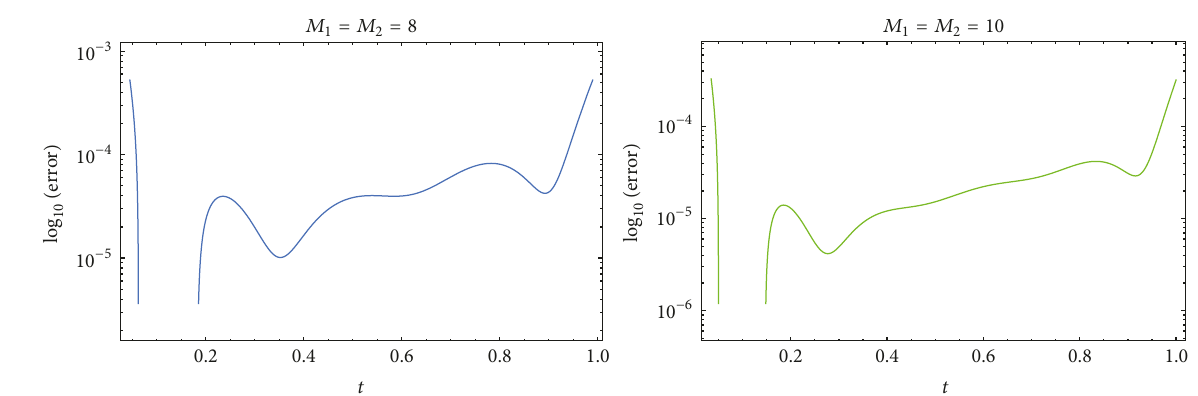
Figure 2: Graph of the Bernoulli wavelet approximation error for 𝑟 = 1 and 𝑡 ∈ [0, 1) of Example